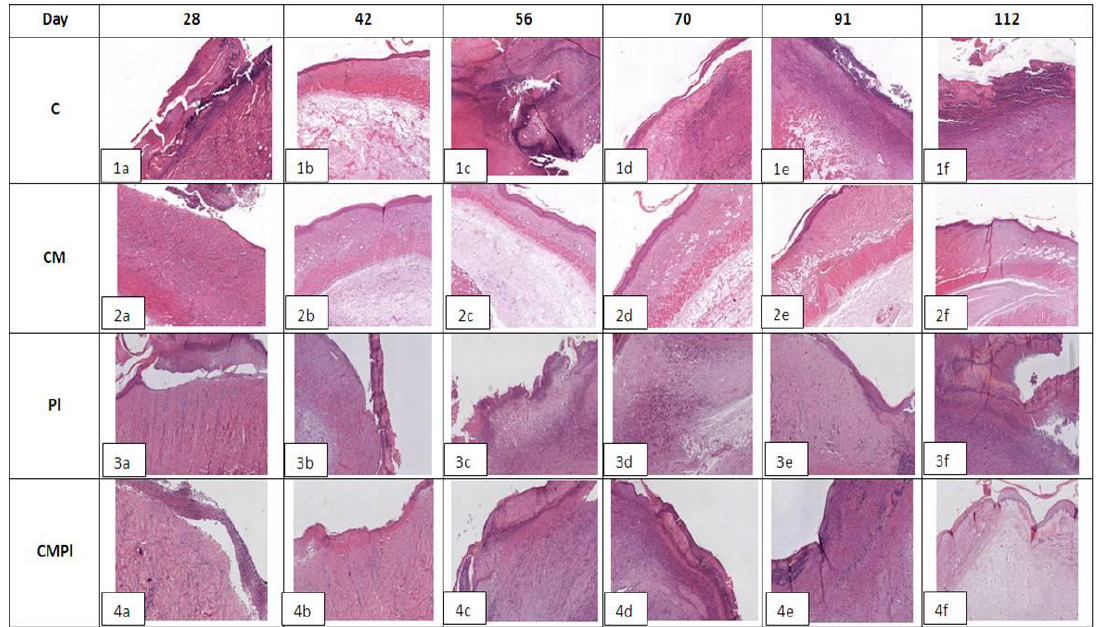
Figure3. Histologicalexaminationofanimalskindefects. Hemotoxylin-eosinstaining, × 40magnification Figure 3. Histological examination of animal skin defects. Hemotoxylin‒eosin staining, X40 for C and CM groups, × 20 for PL and CMPl groups (C: irradiated rats without subsequent therapy, CM: magnification for C and CM groups, X20 for PL and CMPl groups (C: irradiated rats without irradiated rats that received intradermal administration of culture medium (MesenCult) concentrate, subsequent therapy, CM: irradiated rats that received intradermal administration of culture medium PL: therapy of LRI using MSCs derived from the placenta, CMPL: therapy of LRI using a concentrate of (MesenCult) concentrate, PL: therapy of LRI using MSCs derived from the placenta, CMPL: therapy conditioned medium collected from the culture of the of LRI using a concentrate of conditioned medium collected from the culture of the MSCs).